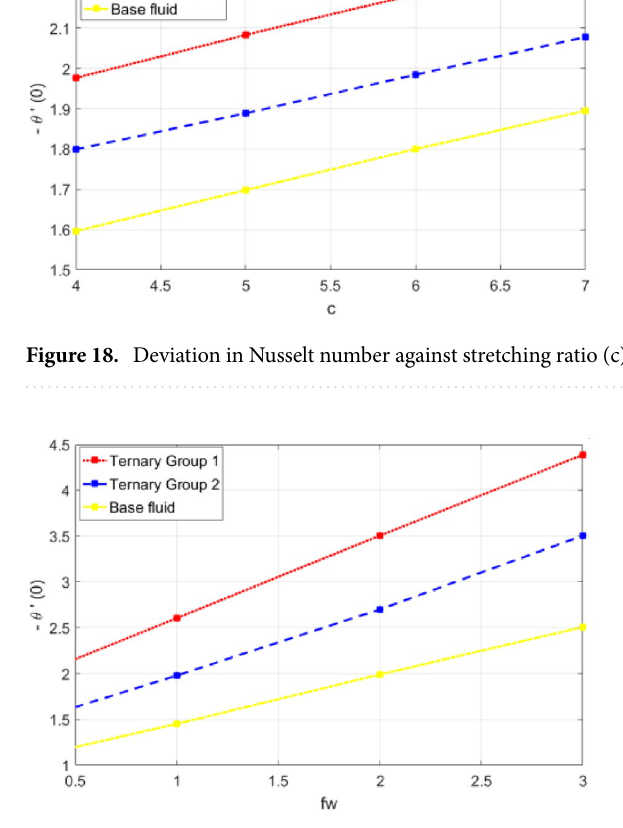
Figure 19. Deviation in Nusselt number against suction velocity ( f w ) .